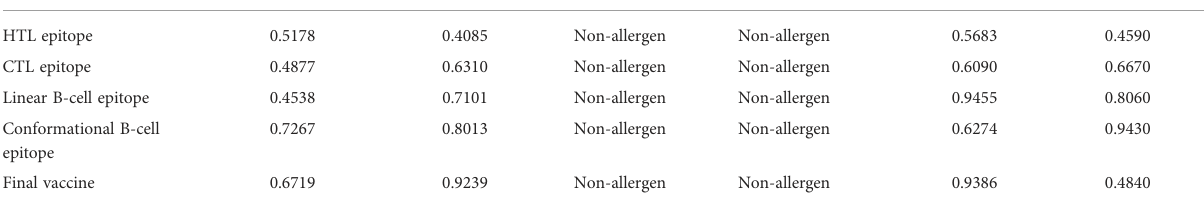
TABLE 7 Evaluation of the antigenicity, allergenicity, and solubility of the vaccine.